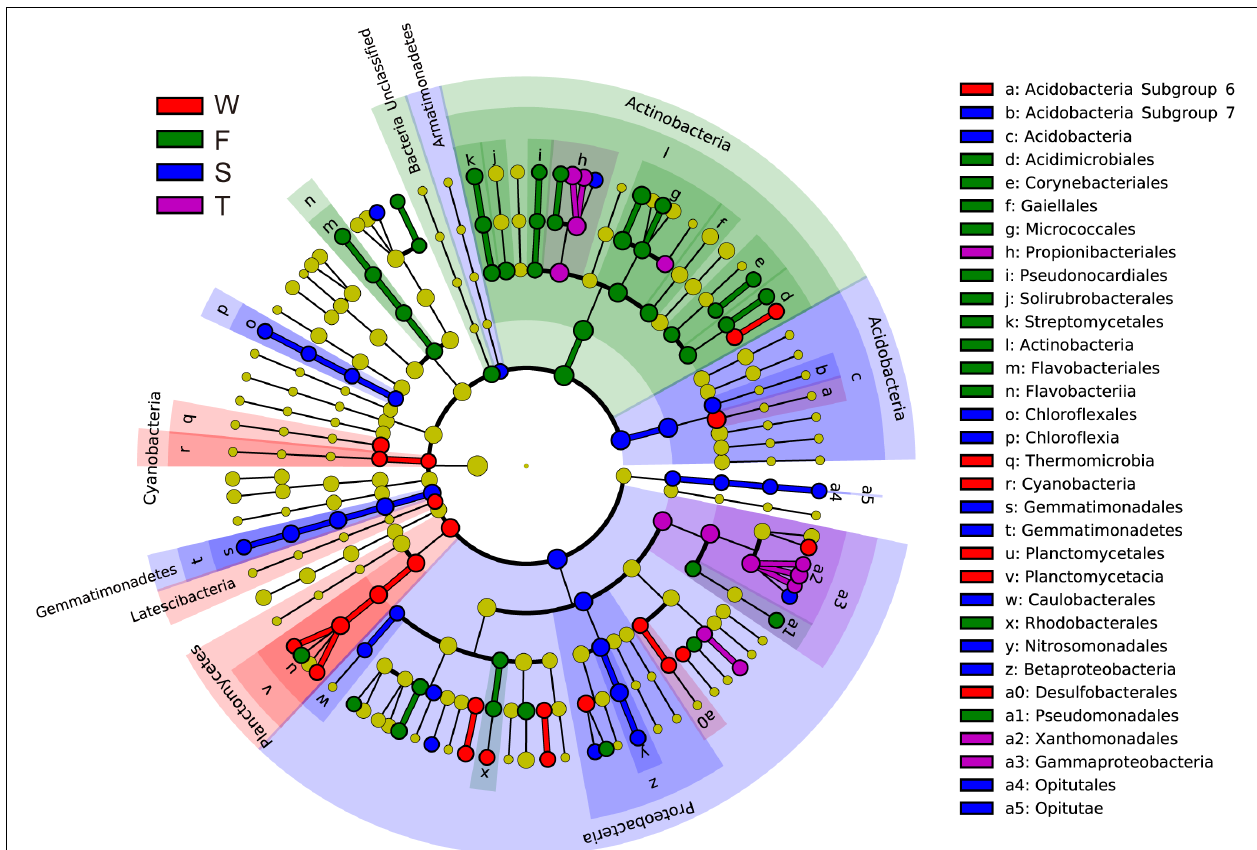
FIGURE 2 | Cladograms, generated from LEfSe analysis, represent the polygenetic distribution of soil bacterial taxa. Biomarkers that are significantly associated with each treatment with LDA scores larger than 2 are shown. Significantly discriminant taxon nodes are colored: red for the wheat field (W), green, blue and purple for the first (F), second (S), and third (T) cropping of Jerusalem artichoke (JA), respectively. Yellow circles represent non-significant differences in abundance between treatment groups for that particular taxon. Each circle’s diameter is proportional to the taxon’s abundance. Labels are shown of the phylum, class and order levels. The LDA scores of each identified biomarker from the phylum to genus levels are shown in Supplementary Figure S1.